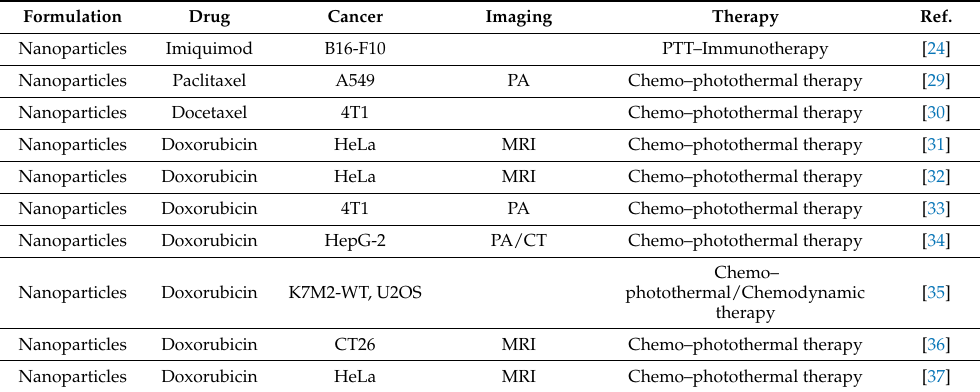
Table 1. Mesoporous polydopamine applied in tumor